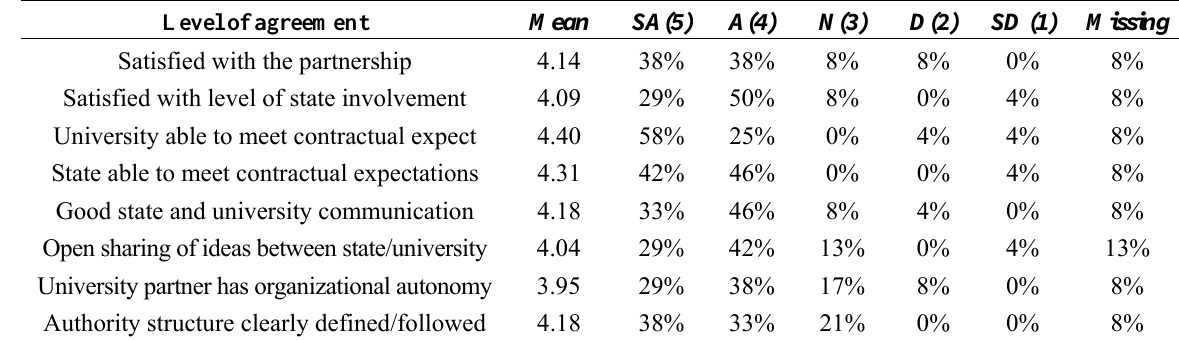
Table 1. Ratings of perceptions of collaboration (N = 24).